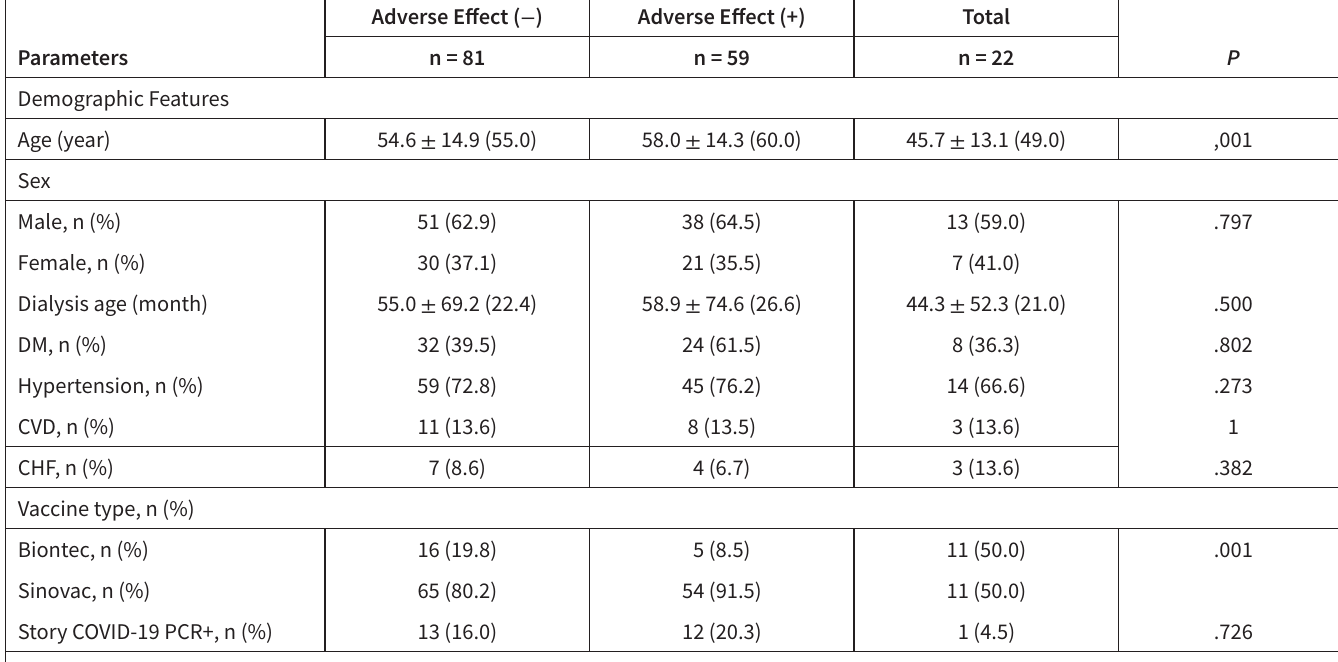
Table 4. Characteristics of Patients Classified According to the Presence of Adverse Events After the COVID-19 Vaccines